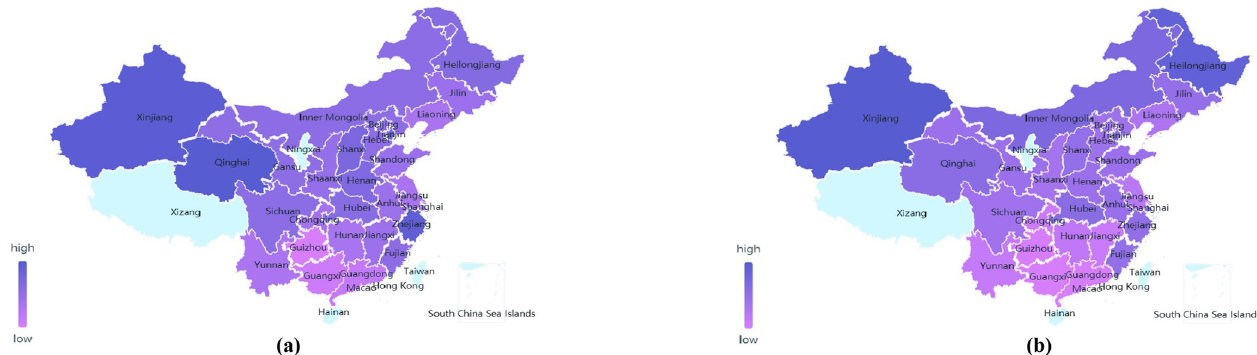
Fig 10. National eggplant price map in February 2019 (a) and February 2020